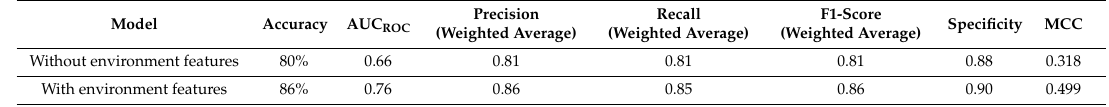
Table 2. Evaluation statistics (five-fold cross validation) for Random Forest classifier with and without environmental